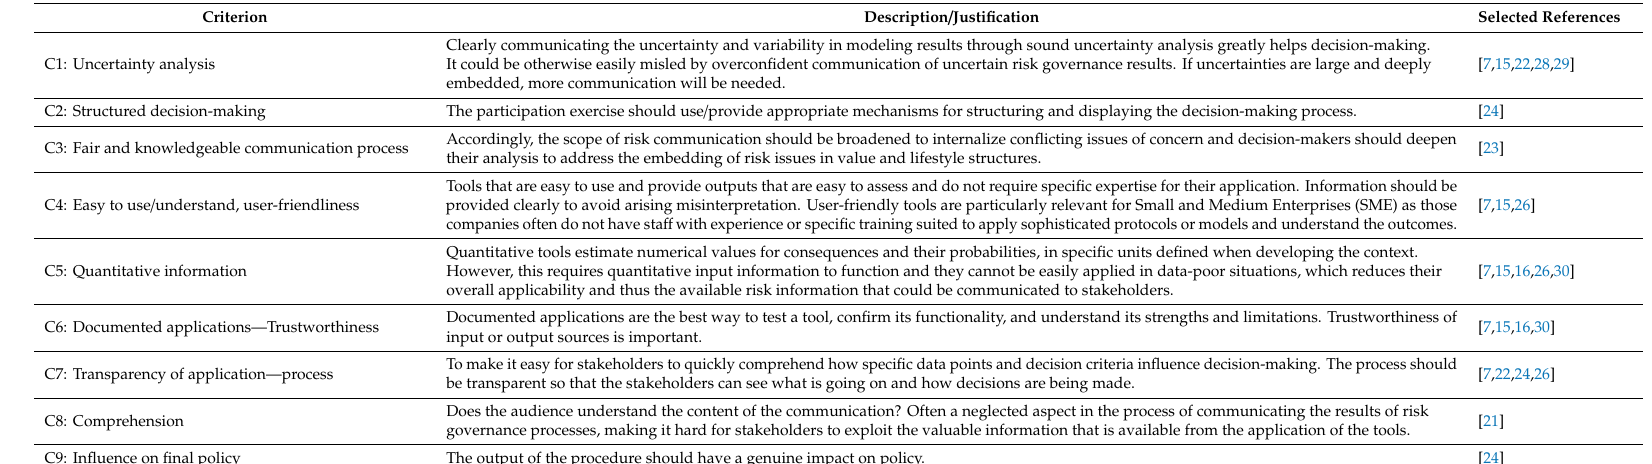
Table 1. Selected relevant criteria for the evaluation of risk governance